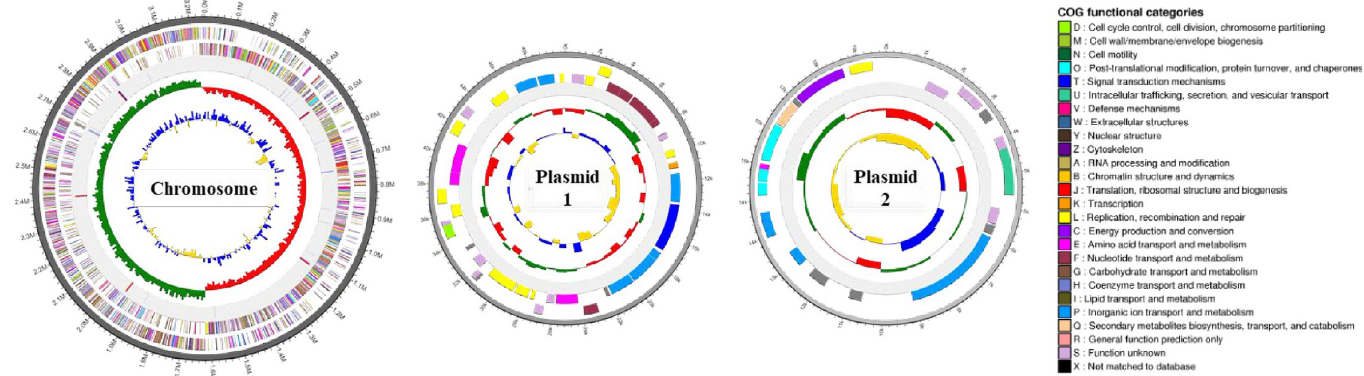
Fig 1. Graphical genome maps of the Lactiplantibacillus plantarum PMO 08 chromosome and plasmids. Circles represent the following characteristics from the outermost circle to the center: (1) contig information, (2) coding sequences on forward strand, (3) coding sequences on reverse strand, (4) tRNAs and rRNAs, (5) GC skew, and (6) GC ratio. G, guanine; C, cytosine.